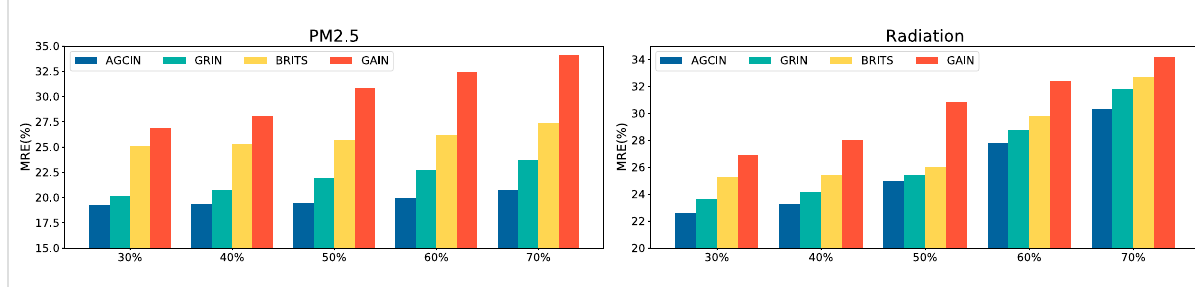
FIGURE 4 A comparison of baselines and AGCIN across varied data missingness ratios on PM2.5 and radiation datasets.